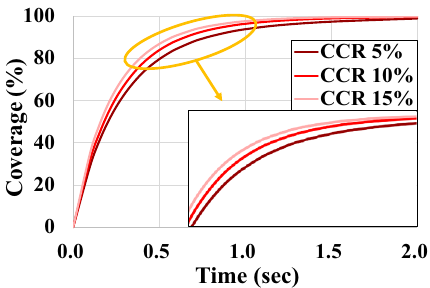
Figure 13. Coverage of concave models according to concave ratio.